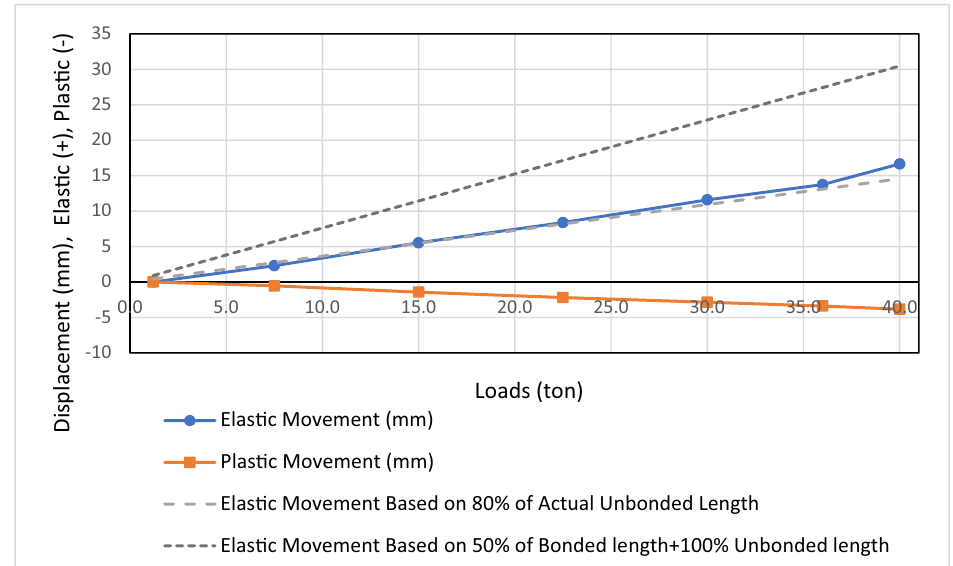
Figure 12: Load – elastic and plastic displacements for anchor